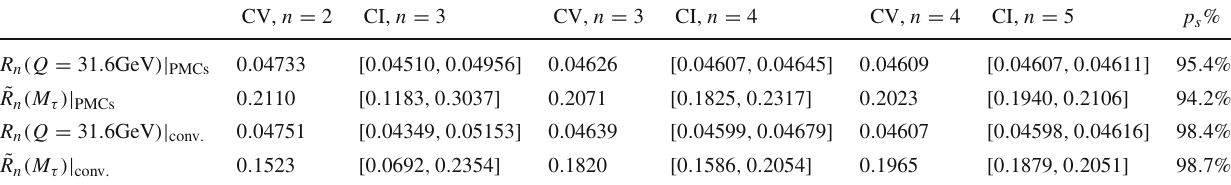
Fig. 4 Comparison of the calculated central values (“CV”) of the setting, respectively. The blue solid triangles and red solid quadrates with error bars represent the predicted p s % CIs using the Bayesian- pQCD approximants R n ( Q = 31 . 6 GeV ) and ˜ R n ( M τ ) for n = ( 1 , 2 , 3 , 4 ) with the predicted p based approach based on the PMCs conformal series ( p s = 95 . 4 for s % credible intervals (CI) of those R n ( Q = 31 . 6 GeV ) , p s = 94 . 2 for ˜ R n ( M τ ) ) and the conventional approximants for n = ( 2 , 3 , 4 , 5 ) . The blue hollow triangles and red hollow quadrates represent the calculated central values of the fixed- (Conv.) scale-dependent series ( p s = 98 . 4 for R n ( Q = 31 . 6 GeV ) , p s = 98 . 7 for ˜ R n ( M τ ) ), respectively order pQCD predictions using PMCs and conventional (Conv.) scale- Table 6 Comparison of the calculated central values (“CV”) with the respectively. The DoB of the CI ( p s %) is given in the last column. The predicted p s % credible intervals (“CI”) of the pQCD approximants results for the PMC conformal series are scale-independent. The results R n ( Q = 31 . 6GeV ) and ˜ R n ( M τ ) based on the PMC conformal series for the conventional scale-dependent series are calculated at μ r = Q andtheconventional(conv.)scale-dependentseriesupto n th -orderlevel, and M τ for R n ( Q = 31 . 6GeV ) and ˜ R n ( M τ ) ,